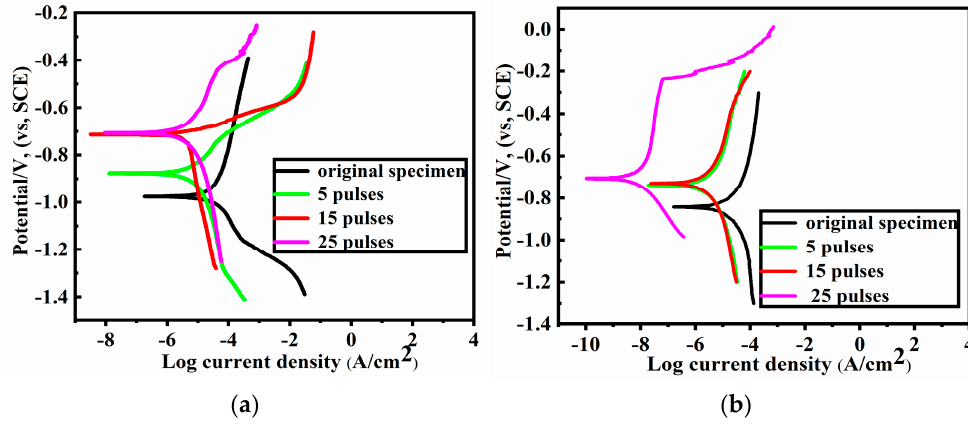
Figure 9. Electrochemical polarisation curves of HCPEB-irradiated and HCPEB-unirradiated Al–20Si–5Mg and Al–20Si–5Mg–0.7Ce alloy surfaces. ( a ) Al–20Si–5Mg alloy; ( b ) Al–20Si–5Mg– 0.7Ce alloy. Table 2. Electrochemical parameters obtained in electrochemical analysis.